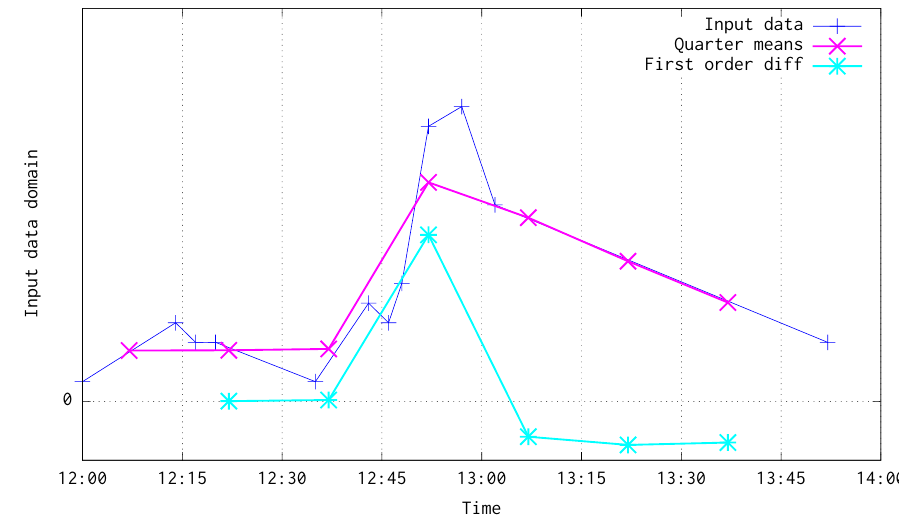
Figure 7. Illustration of input data, means and first order differentiated